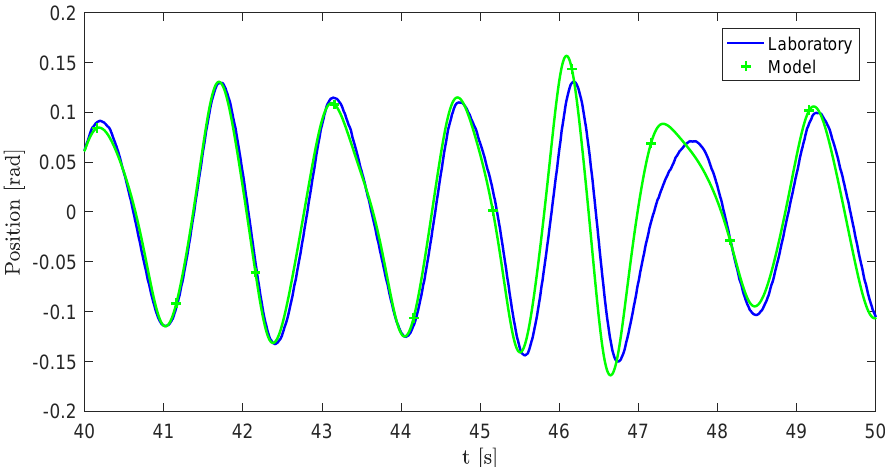
Figure 17. Angular displacement time series comparison for Setup 5 and wave conditions S2 where the blue solid line corresponds to laboratory measurements, while the green solid line with crosses corresponds to the simulation results.